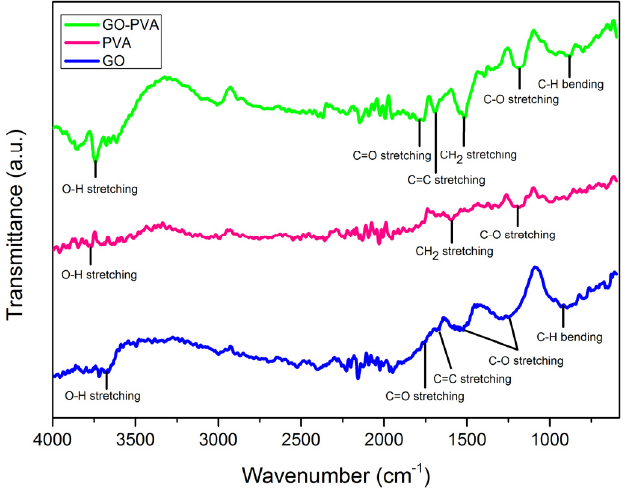
Figure 3. Fourier transform infrared spectroscopy (FTIR) spectra of GO, PVA, and GO–PVA thin